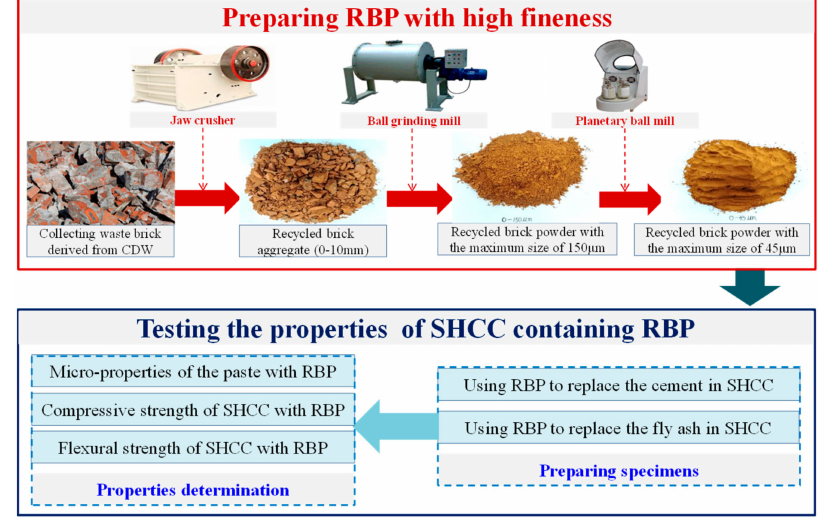
Figure 1. Flow diagram of using the waste bricks in CDW to prepare RBP.